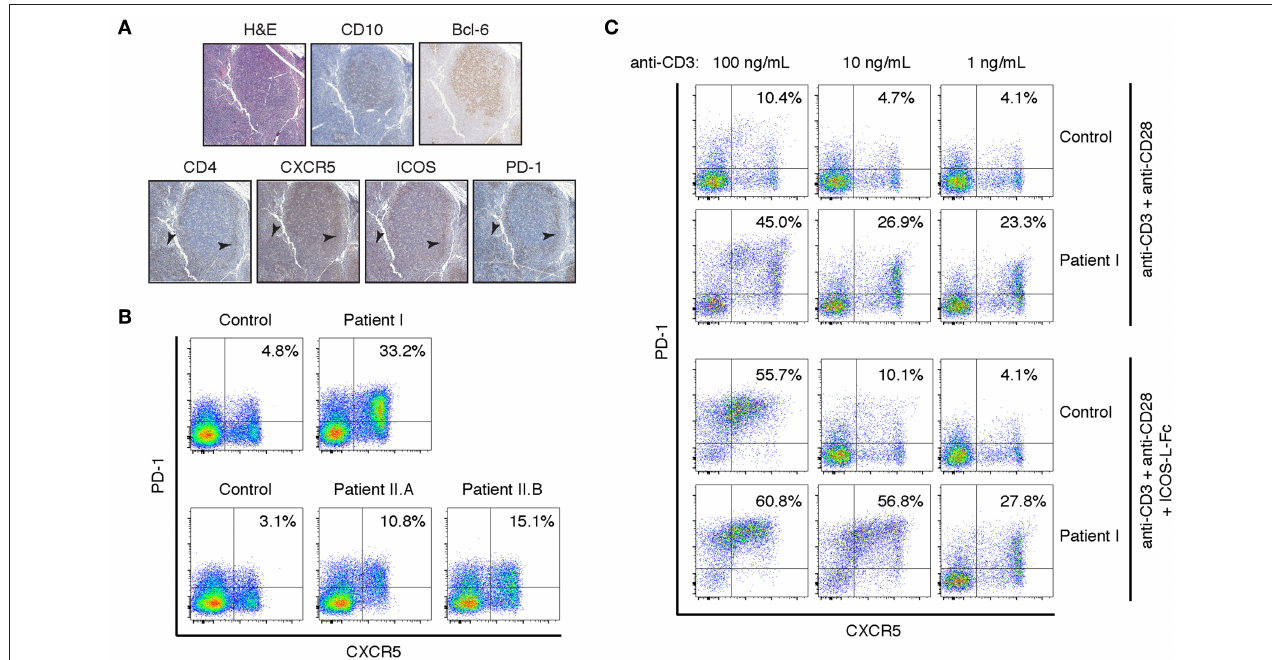
FIGURE 2 | Peripheral and lymph node CD4 + T cells have a T FH phenotype in the Y524S APDS patient. (A) Serial sections of a lymph node biopsy from the patient stained for H&E, CD10, CD4, Bcl-6, CXCR5, ICOS, and PD-1. Arrowheads indicate areas of CD4 + cells that are also positive for CXCR5, ICOS, and PD-1. (B) FACS analysis of CXCR5 and PD-1 on CD4 + T cells from fresh control and patient PBMCs. (C) CXCR5 and PD-1 expression on activated T cells. Freshly isolated CD4 + T cells from control and Patient I were stimulated for 4 days with the indicated concentrations of plate-bound anti-CD3, with or without 2 ug/mL ICOS-L-Fc. Anti-CD28 was included at 1 ug/mL in all cultures. Results are representative of two